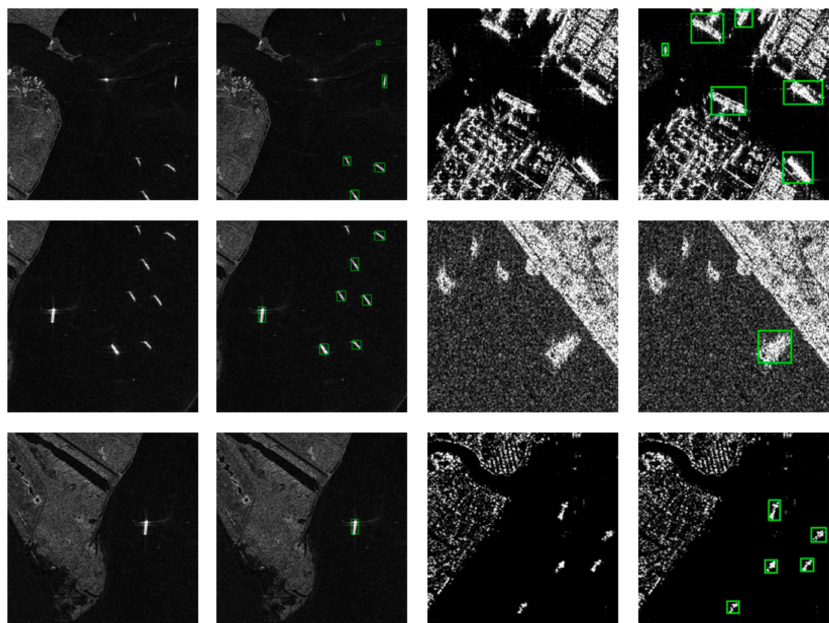
Figure 10. Generalization performance tests, column 1 images from HRSID, column 2 results from column 1, column 3 images from SAR-Ship-Dataset, and column 4 results from column 3.